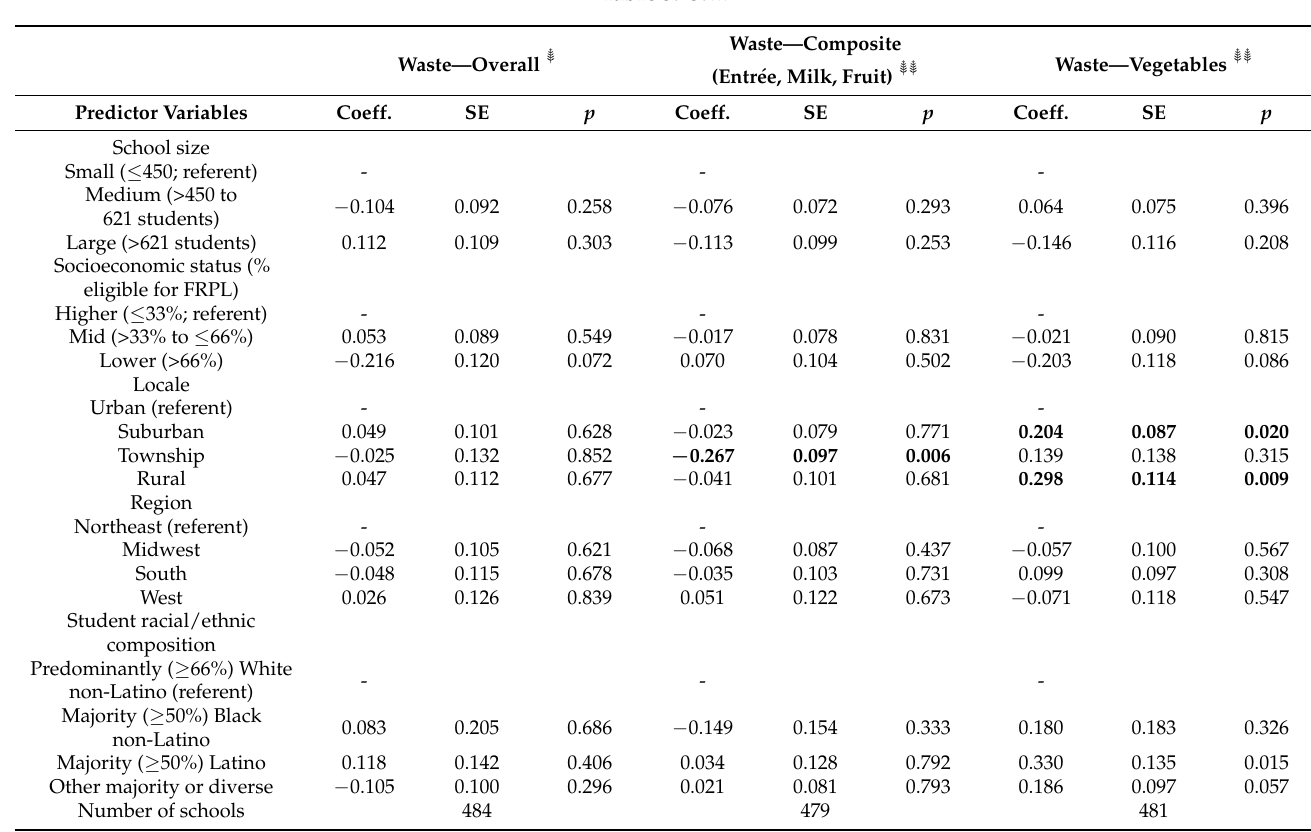
Table 5. Regression models predicting perceived extent of food waste in school lunches. Table 5. Cont . Waste—Overall ⸙